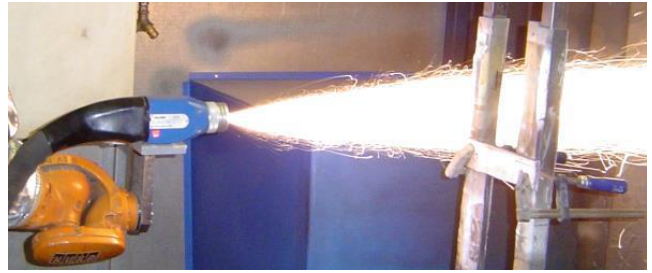
Figure 2. Sulzer VisuArc 350 arc wire spraying system.